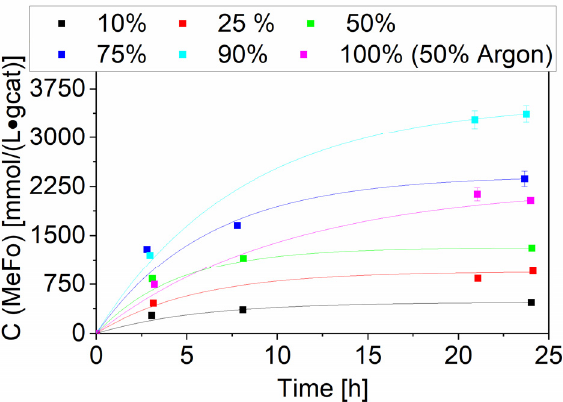
Figure 10. Variation of CO partial pressure for the Ru-NO-5-icr. catalyst. Testing conditions: 80 bar, 150 °C, 50 mL methanol, quantification: GC-FID (PolyArc).